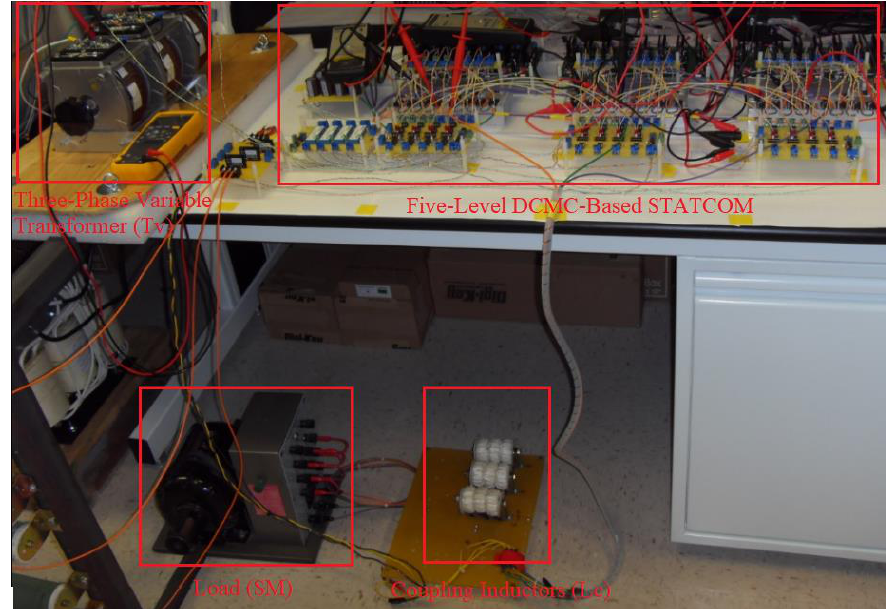
Figure 14. 2 kVA five-level DCMC-based STATCOM prototype.